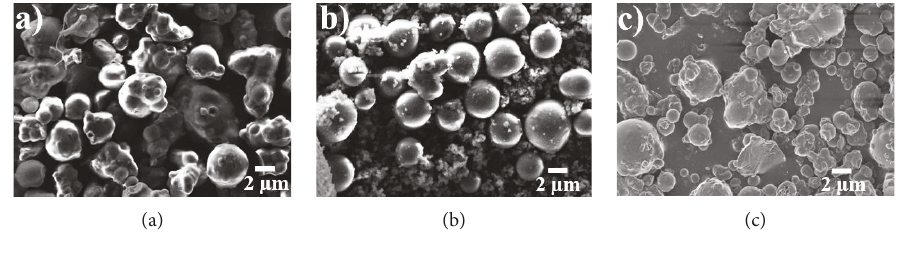
Figure 3: SEM images of (a) C-g-P